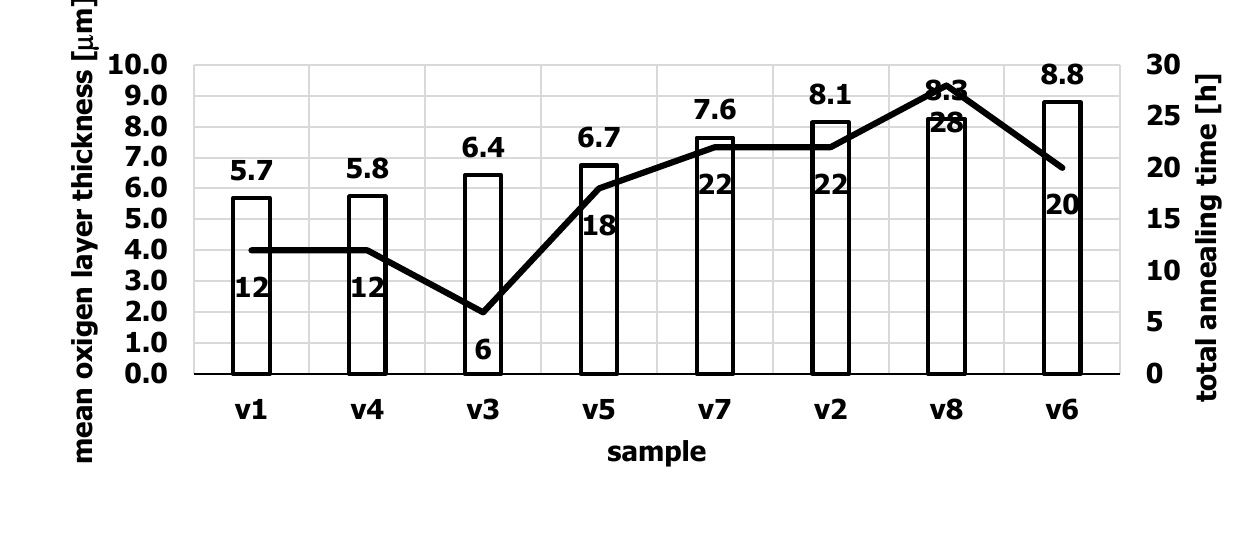
Figure 4. Thickness of the oxide layer of the annealed samples .